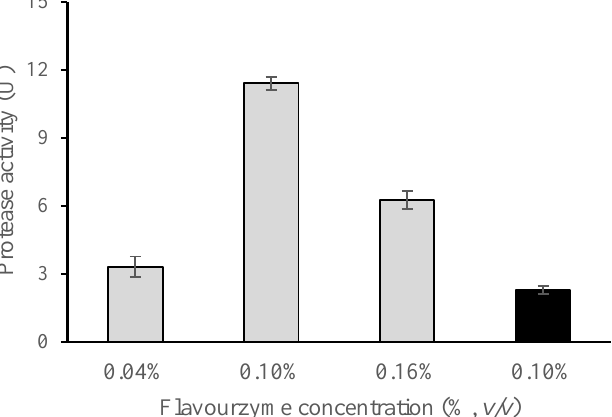
Figure 4. Effect of enzyme concentration on the protease activity of the spray-dried chitosan Flavourzyme ® microparticles. Gray and black columns indicate the inlet temperatures of 130 °C and 160 °C, respectively. Errors bars represent the standard deviation.